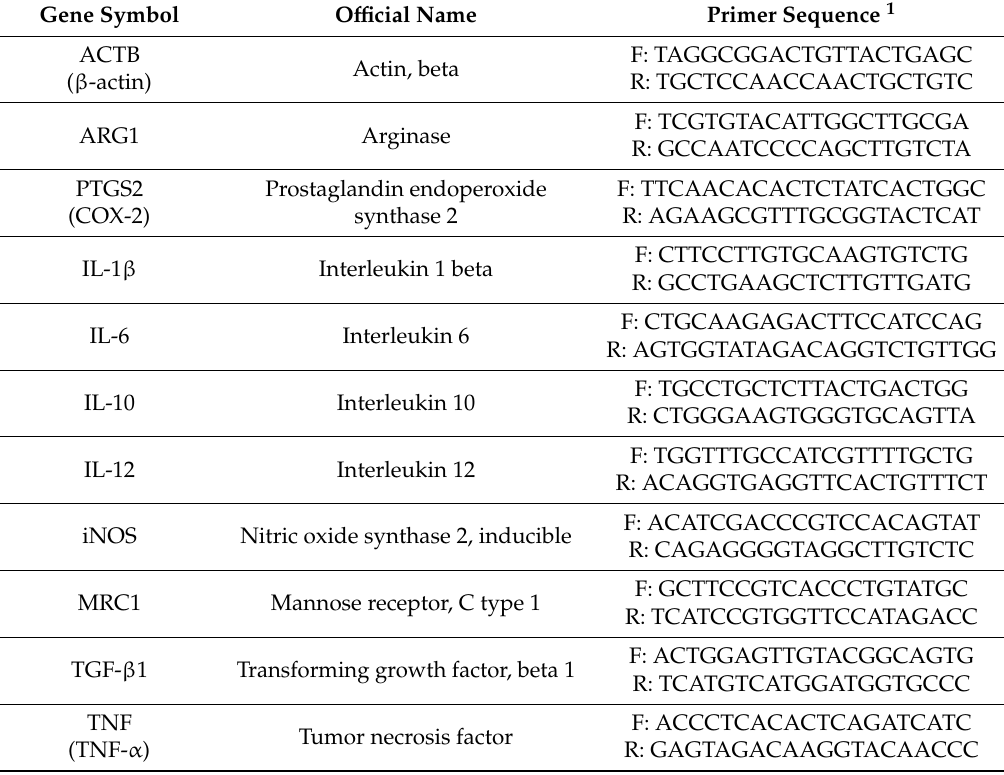
Table 1. Sequences of Primers used for Real-time PCR